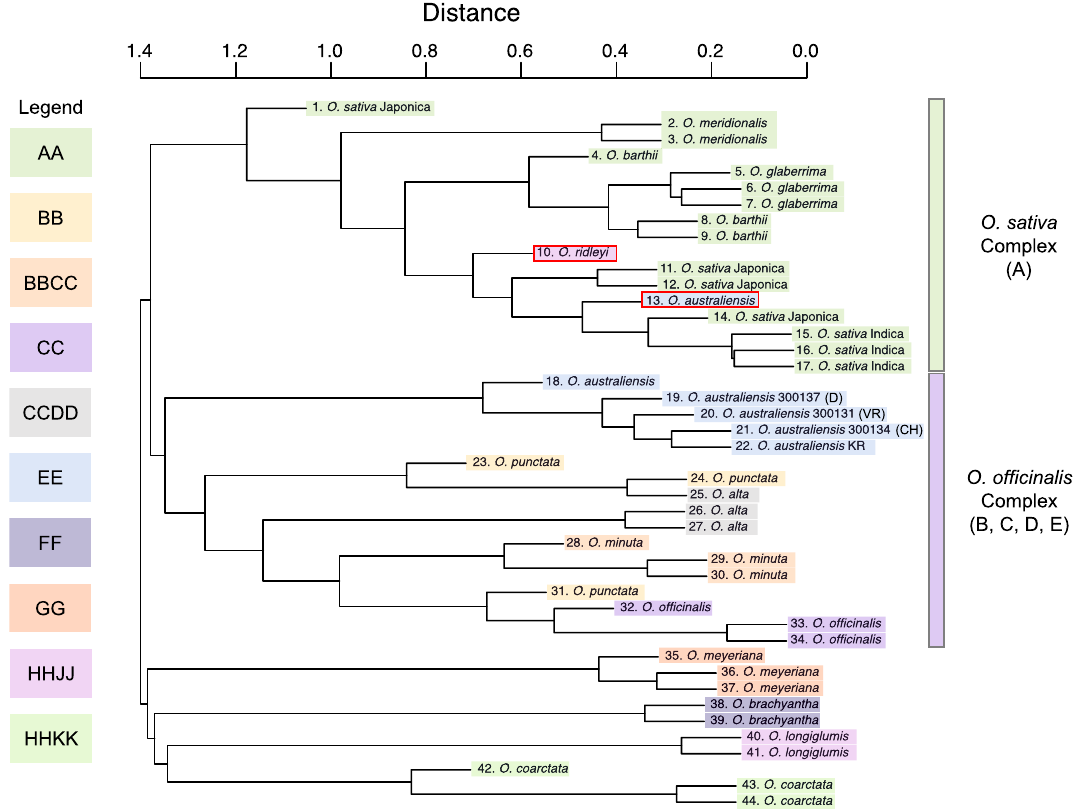
Figure 3. Genetic distance between Oryza species/accessions derived from Illumina short read libraries by kWIP . Samples are coloured based on the Oryza genome clade that they occupy (see inset Legend). kWIP clustered samples into the canonical O. sativa (AA genome) and O. officinalis (BB, CC, BBCC, CCDD, EE genomes) complexes. The O. australiensis lineage is divergent from the rest of the O. officinalis genome complex, suggesting it harbours lineage specific adaptations that could be explored for stress tolerance. Within the O. australiensis lineage, the four genotype samples re-sequenced in the present study (KR, CH, VR, and D) show genetic distances that are correlated with geographic distance. The sample divergence between KR, CH, VR, and D, as well as the other O. australiensis accessions shown here suggests that there may be within-species genomic variation that can also be explored for tolerance to stresses (e.g., genotype-specific tolerance to salt stress). Samples that appear with red borders are suspicious as they did not cluster with their corresponding genome clade. This may be due to errors in the sequencing files that were not corrected prior to running kWIP or may reflect human error during sample preparation for